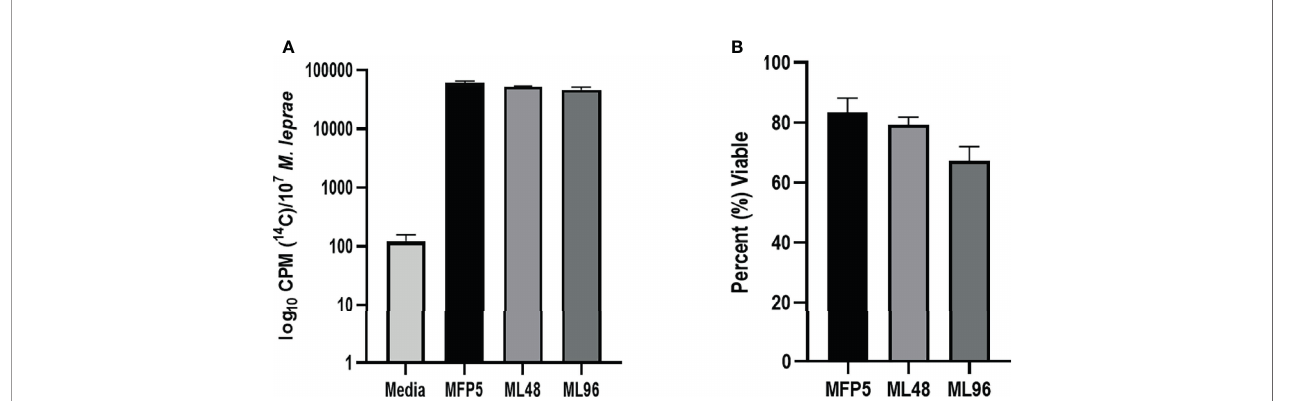
FIGURE 1 | Viability of freshly harvested M. leprae from mouse footpad (MFP5) and following incubation at 33°C in NHDP axenic medium for 48 (ML48) and 96 (ML96) hours. Viability measured by (A) radiorespirometry and (B) syto9/propidium iodide staining. Media alone was used as negative control (Media) for